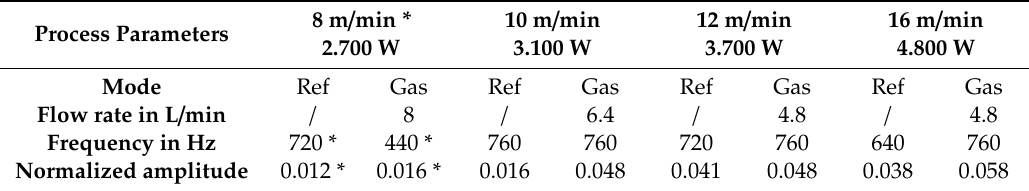
Table 4. Frequency and normalized amplitude of keyhole fluctuation determined by